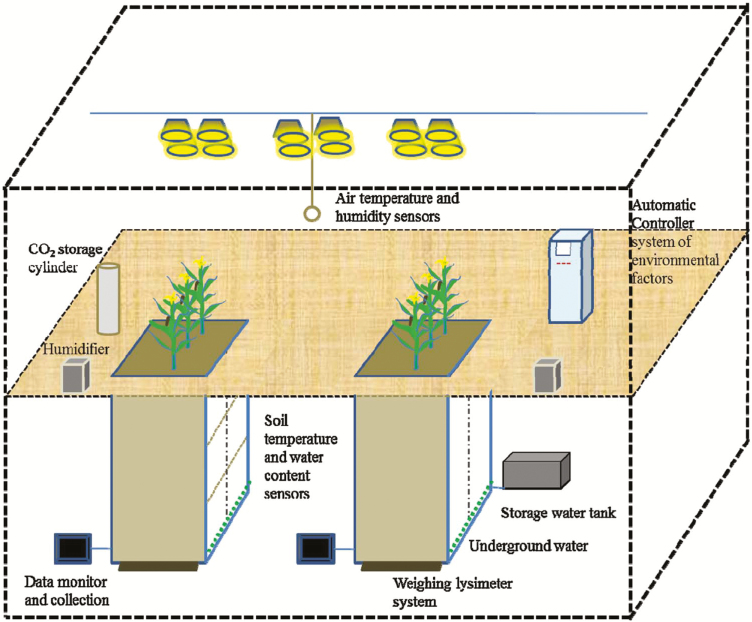
Schematic diagram of the WATDPED (Tan et al., 2017).